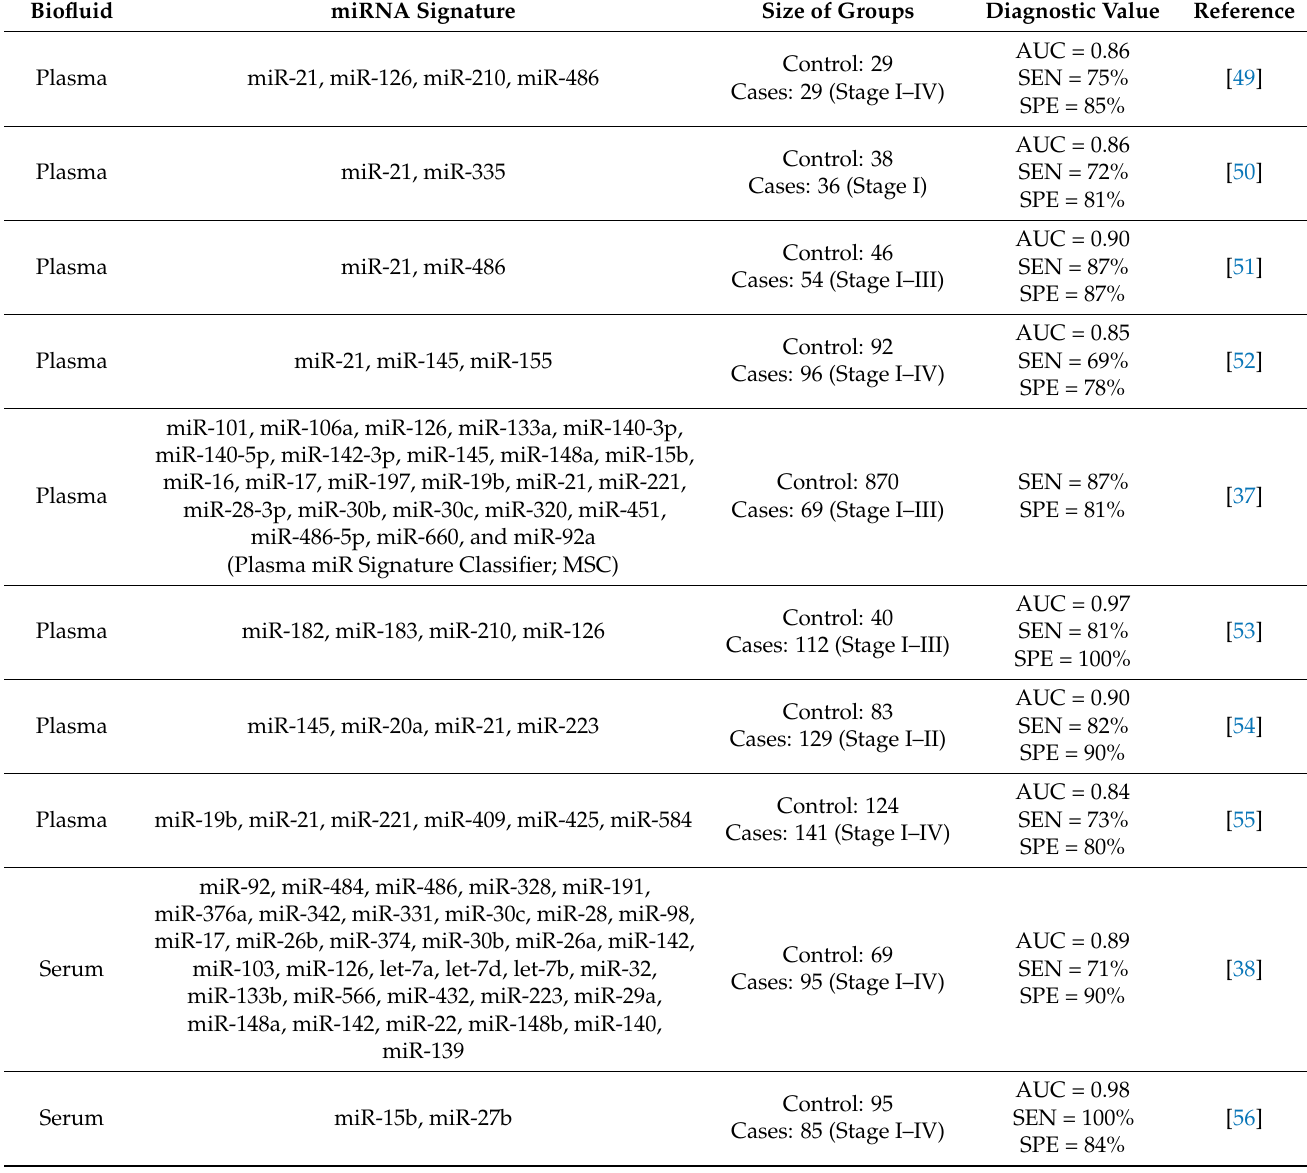
Table 1. Examples of serum/plasma miRNAs as biomarkers of lung cancer.